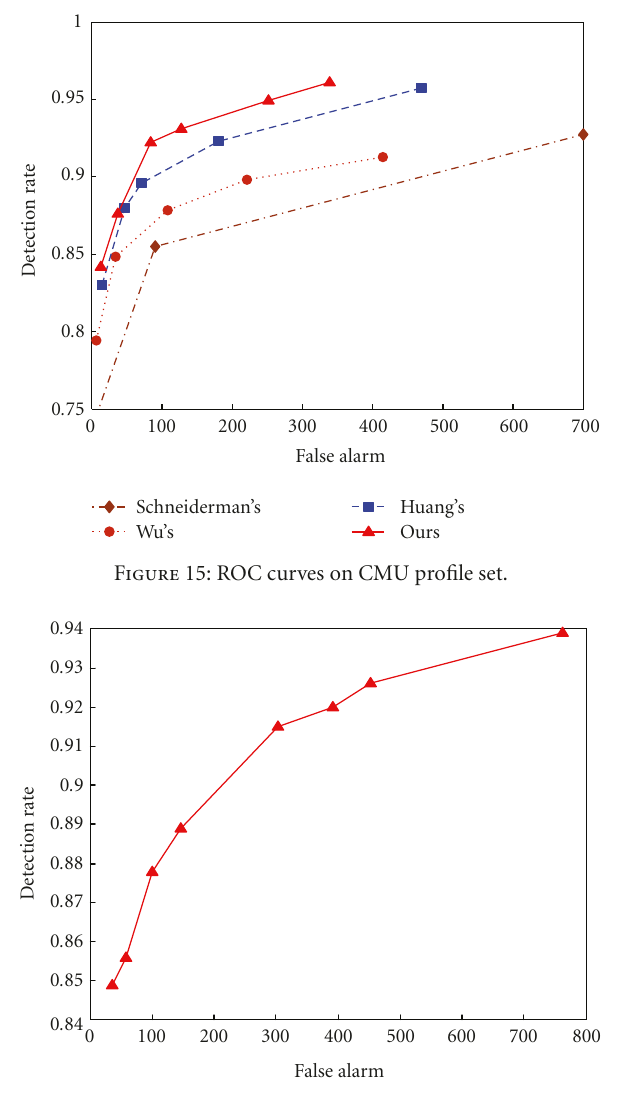
Figure 16: The ROC curve on our own test set.